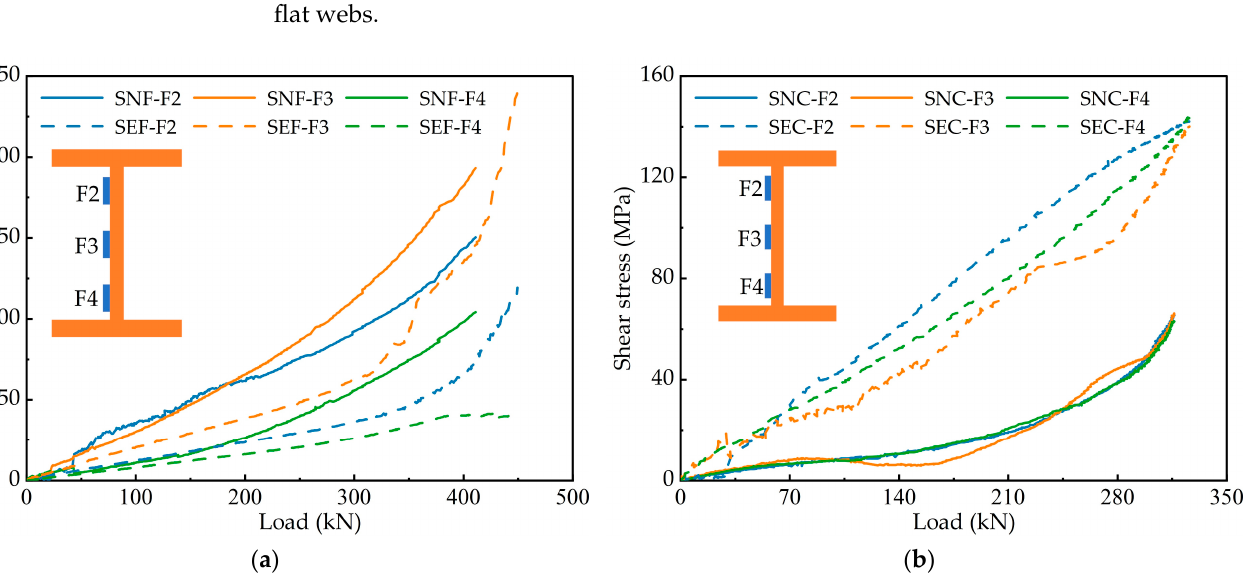
Figure 9. Effect of different concretes on shear stress: ( a ) specimens with flat webs; ( b ) specimens with corrugated webs.